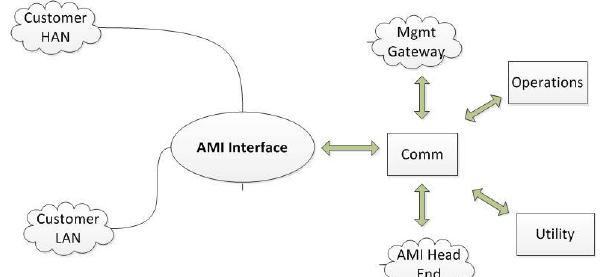
Figure 1. Simple AMI Communication Architecture